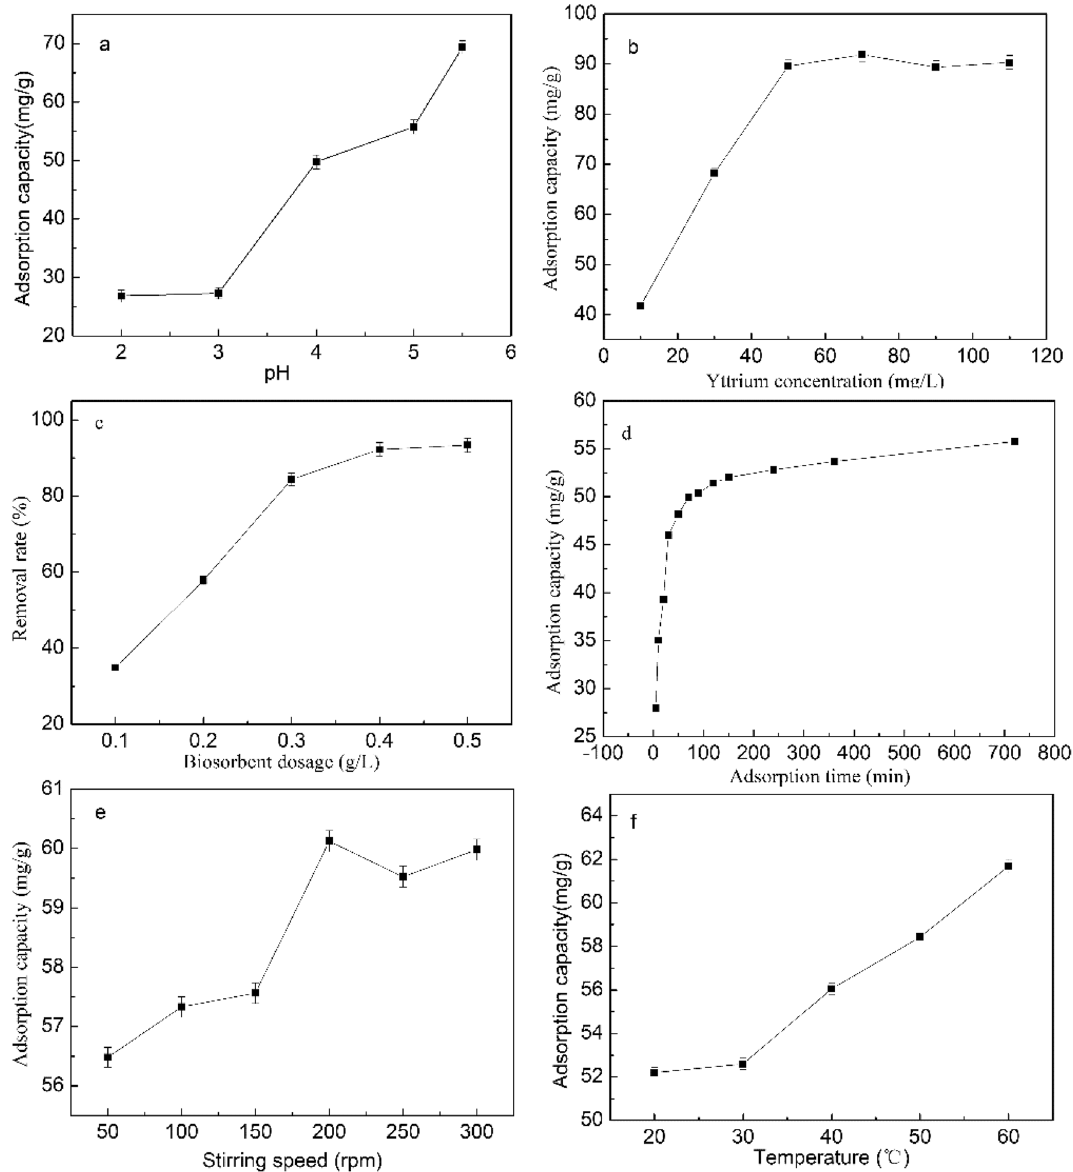
Figure 1. Effect of pH ( a ), initial Y(III) concentration ( b ), biosorbent dosage ( c ), adsorption time ( d ), stirring speed ( e ) and temperature ( f ) on the adsorption capacity of S. marcescens for Y(III) (The initial adsorption quantitative conditions were set as pH ranged from 2 to 5.5, initial Y(III) concentration of 50 mg/L, biosorbent dosage of 0.3 g/L, stirring speed of 150 rpm, biosorption of 25 °C, solution volume of 100 mL and biosorption for 60